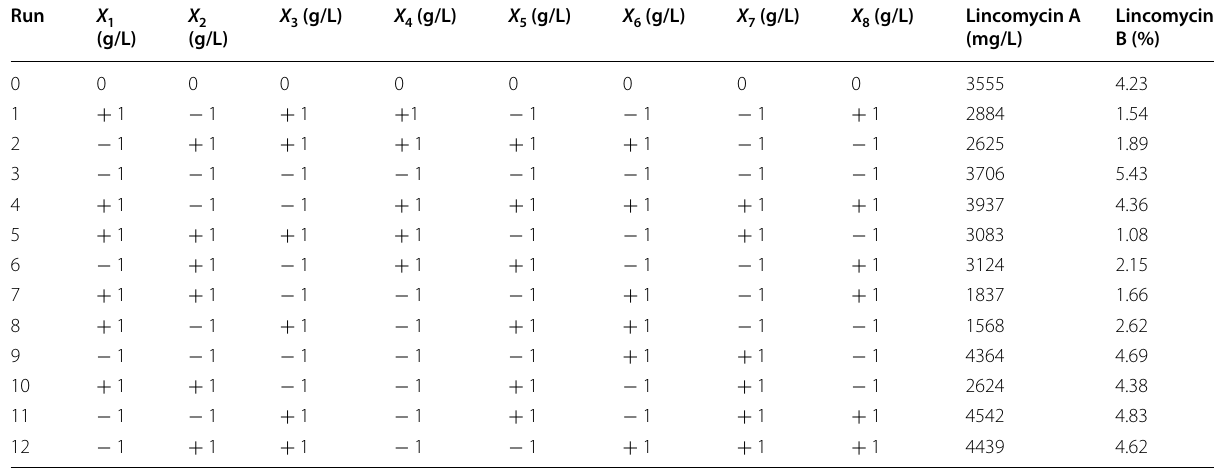
The values were obtained from three independent experiments